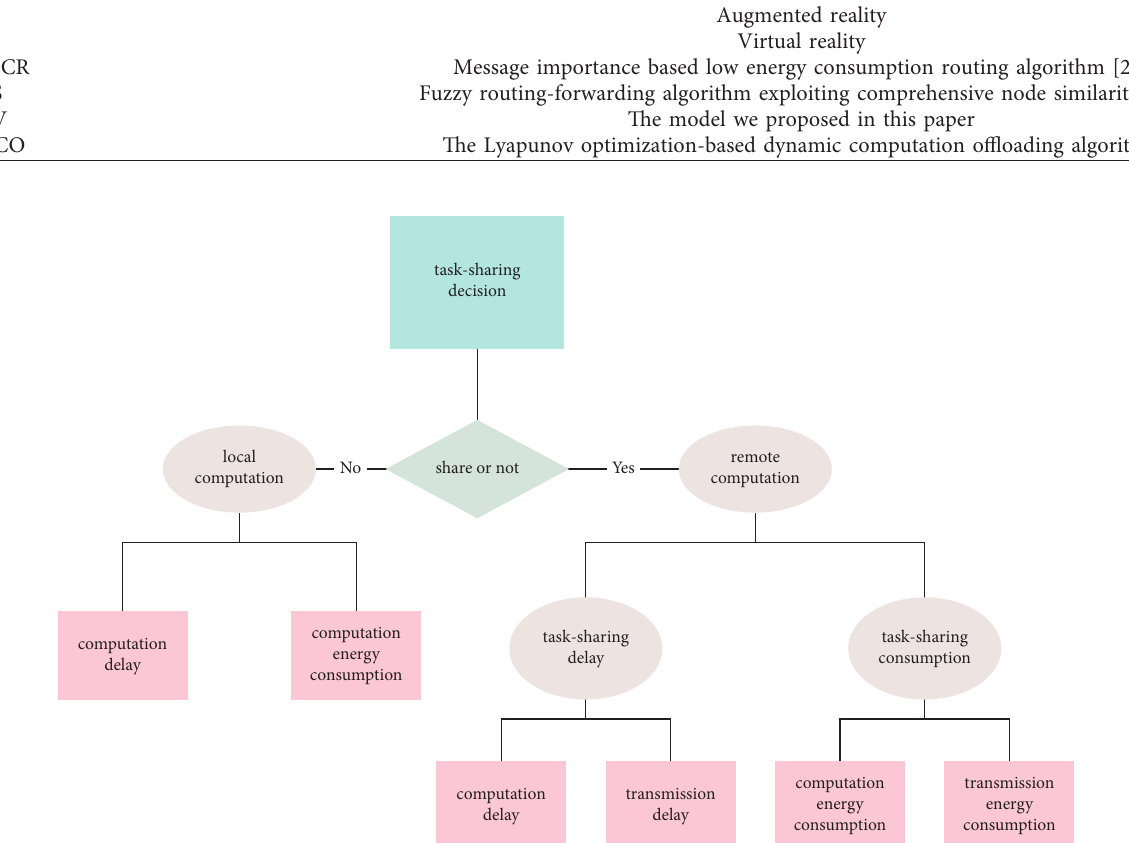
Figure 2: This diagram depicts the task-sharing decision-making